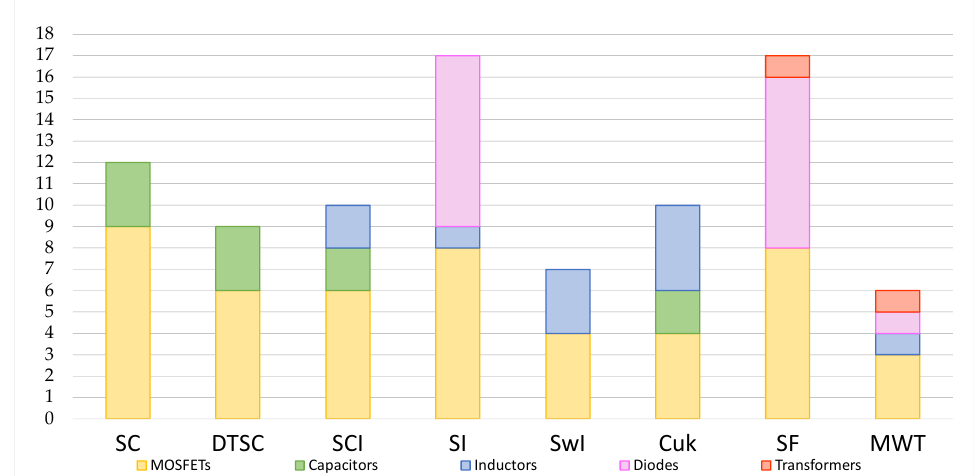
Figure 21. Comparison of the CC–CC converters for active